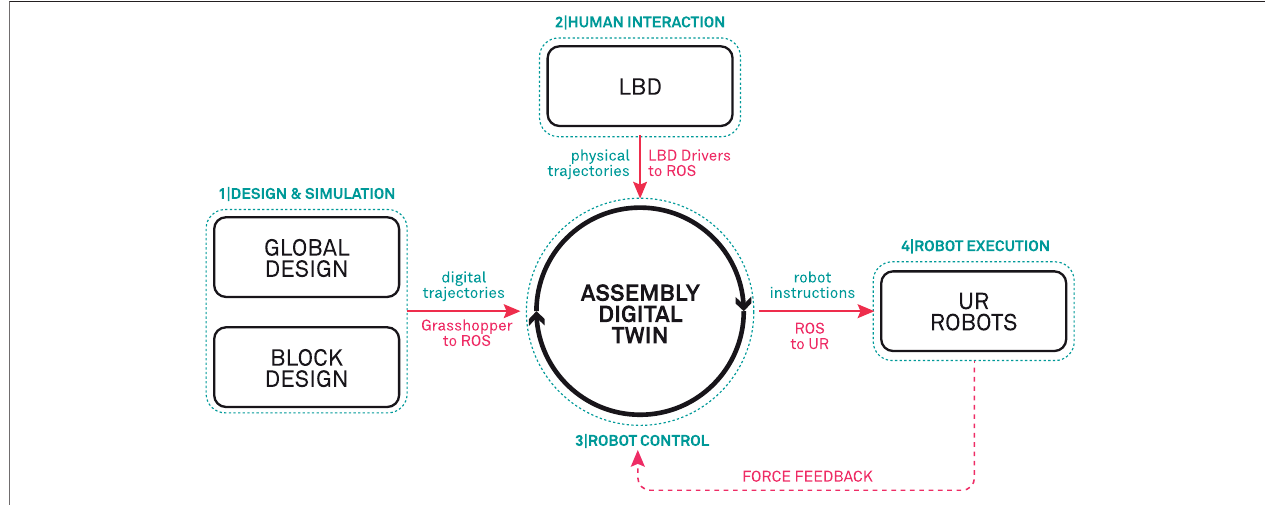
FIGURE 3 | Outline of the digital framework, linking the design and simulation, LbD and the physical level of the robot execution in an assembly digital twin.